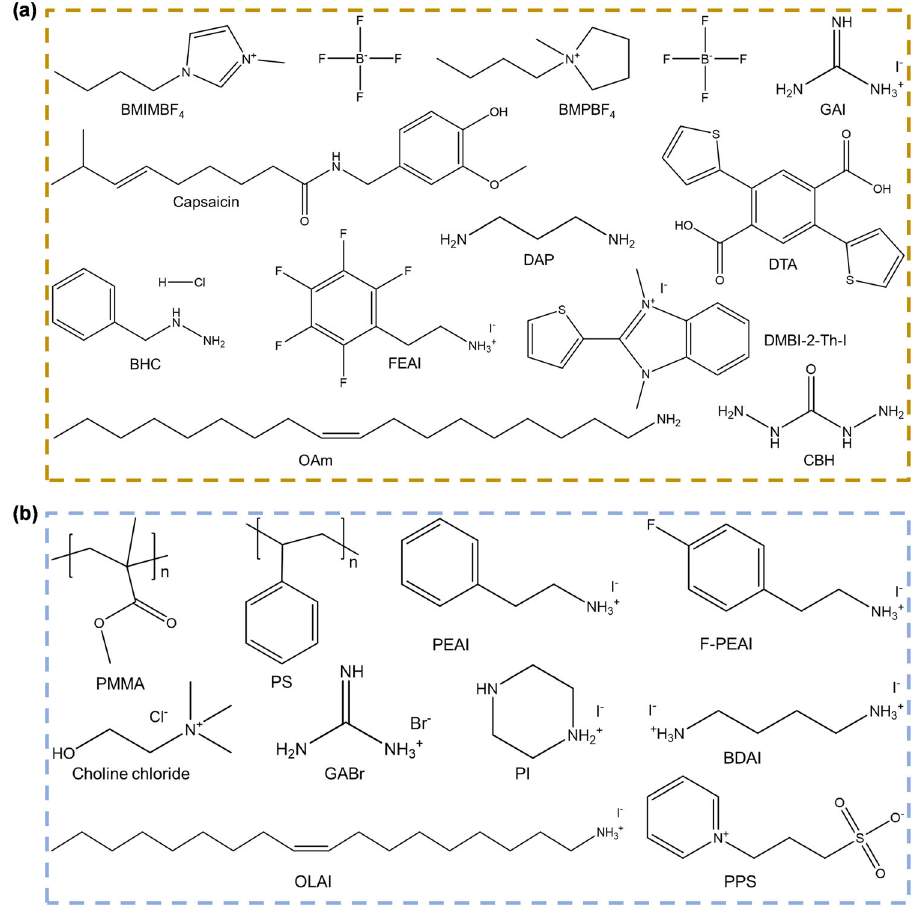
Fig. 3 Typical organic structures for stable IPSCs. a Chemicals added in perovskite. b Chemicals applied at interfaces between the perovskite and charge transport layers. Note that the chemicals of the top row (PMMA, PS, PEAI, F-PEAI) in ( b ) can be applied in different interfaces, such as the HTL/perovskite and